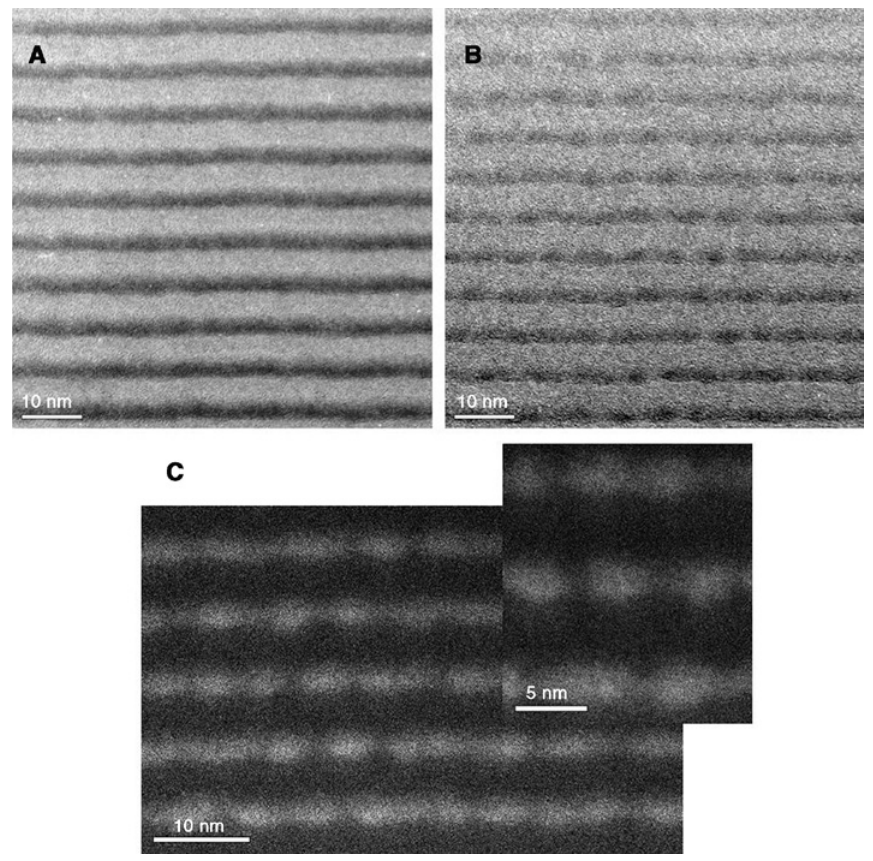
Figure 2: Cross-sectional TEM image of (A) Ge4/Si sample and (B) Ge/Si3 sample and (C) STEM of Ge/Si3 clearly showing QDs of about 3 nm